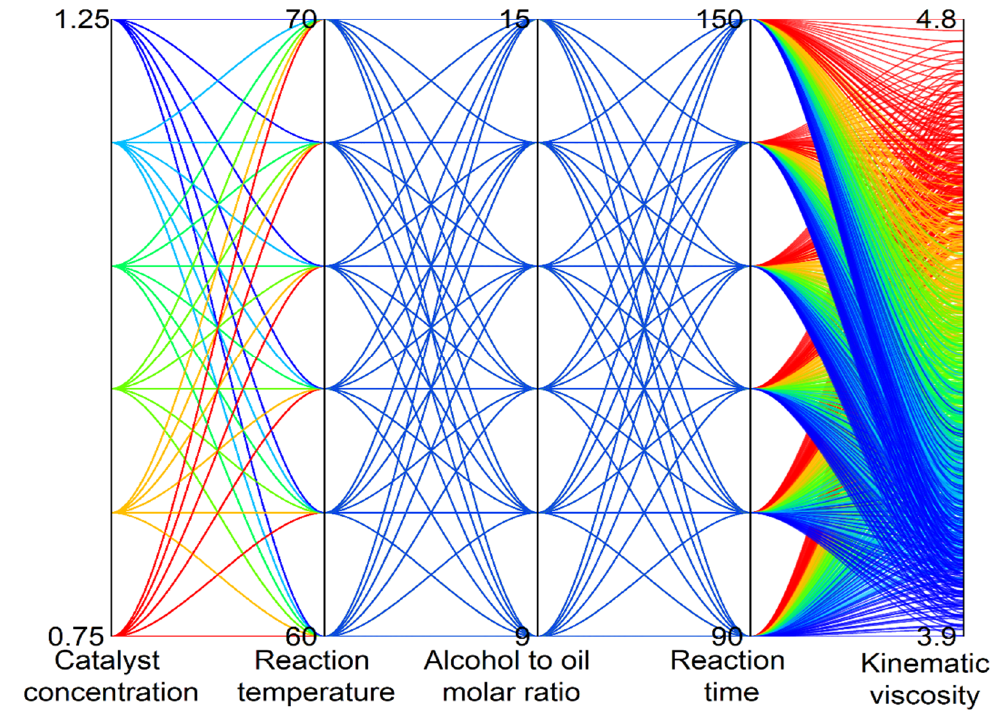
Figure 7. Parallel plot showing the effect of the various process parameters on the kinematic vis-